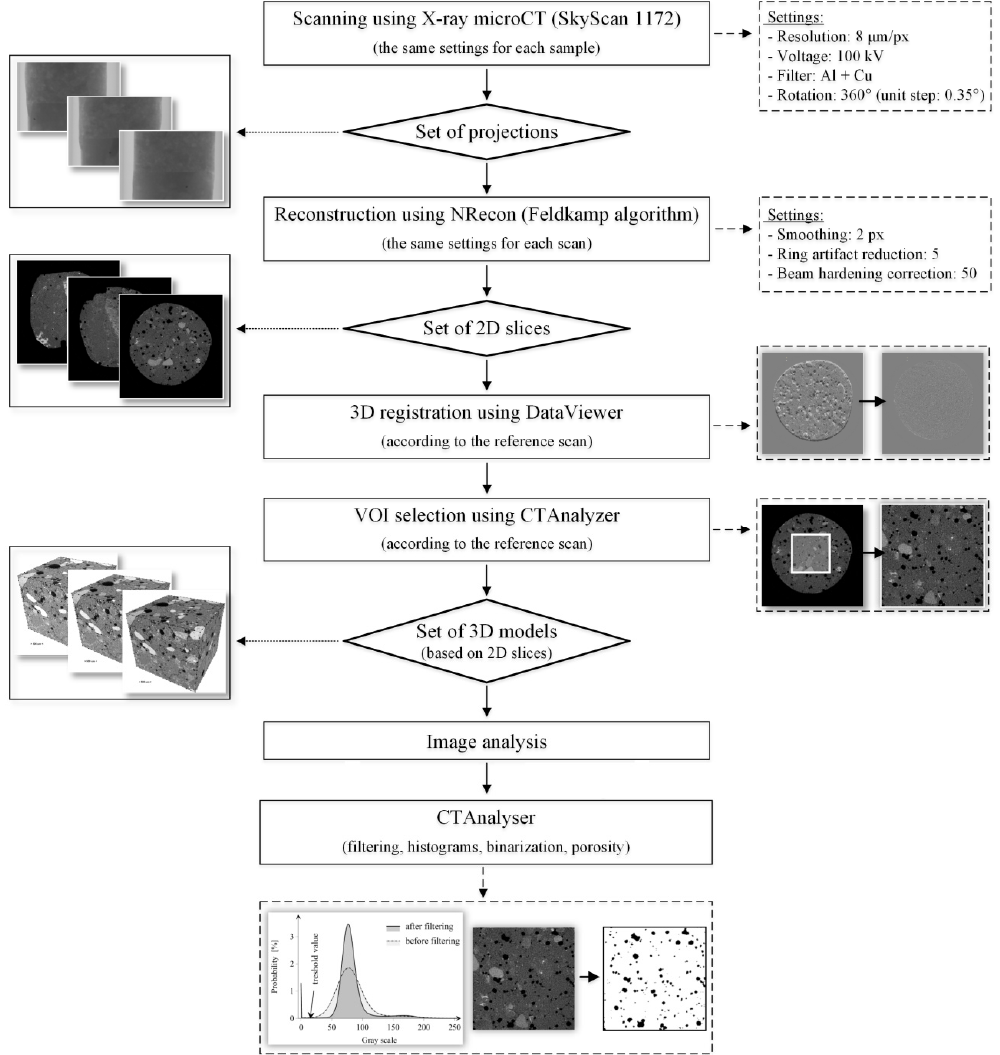
Figure 3. Methodology applied for microstructural evolution within the IZ (interphase zone) between the hardening overlay made of cement mortar and the existing concrete substrate using the micro ‐ CT method.